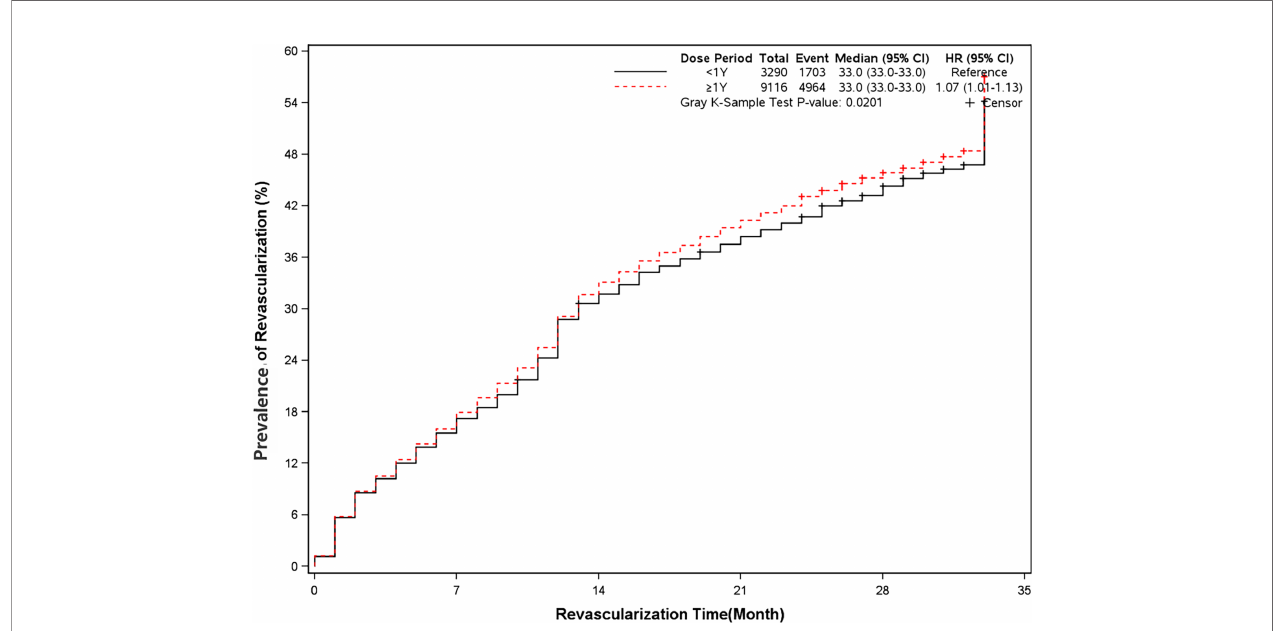
FIGURE 8 | Prevalence of revascularization in two groups. Blackline: patients took clopidogrel continuously < 1 year; Red line: patients took clopidogrel continuously ≥ 1